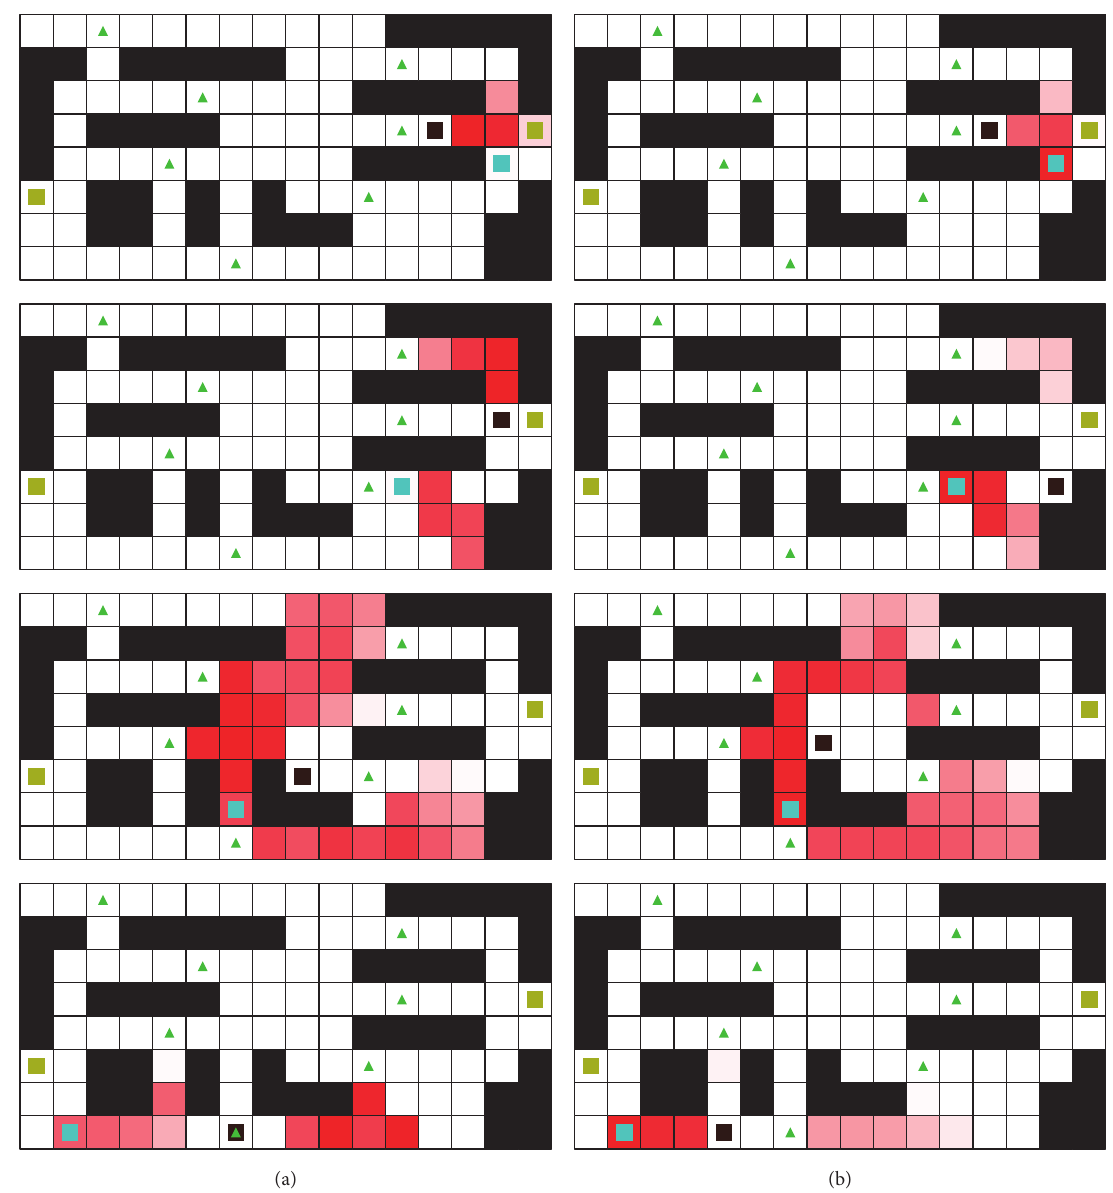
Figure 3: These graphics represent the 12th, 16th, 24th, and 30th turn of two games. (a) is the first game against a new player, while the graphics in (b) are from the tenth game against the same player. The turquoise square represents the human player, the intelligence’s avatar is the dark brown square, the green triangles represent the parrots, and objectives are represented by the golden squares. The player used the exact same path in all ten